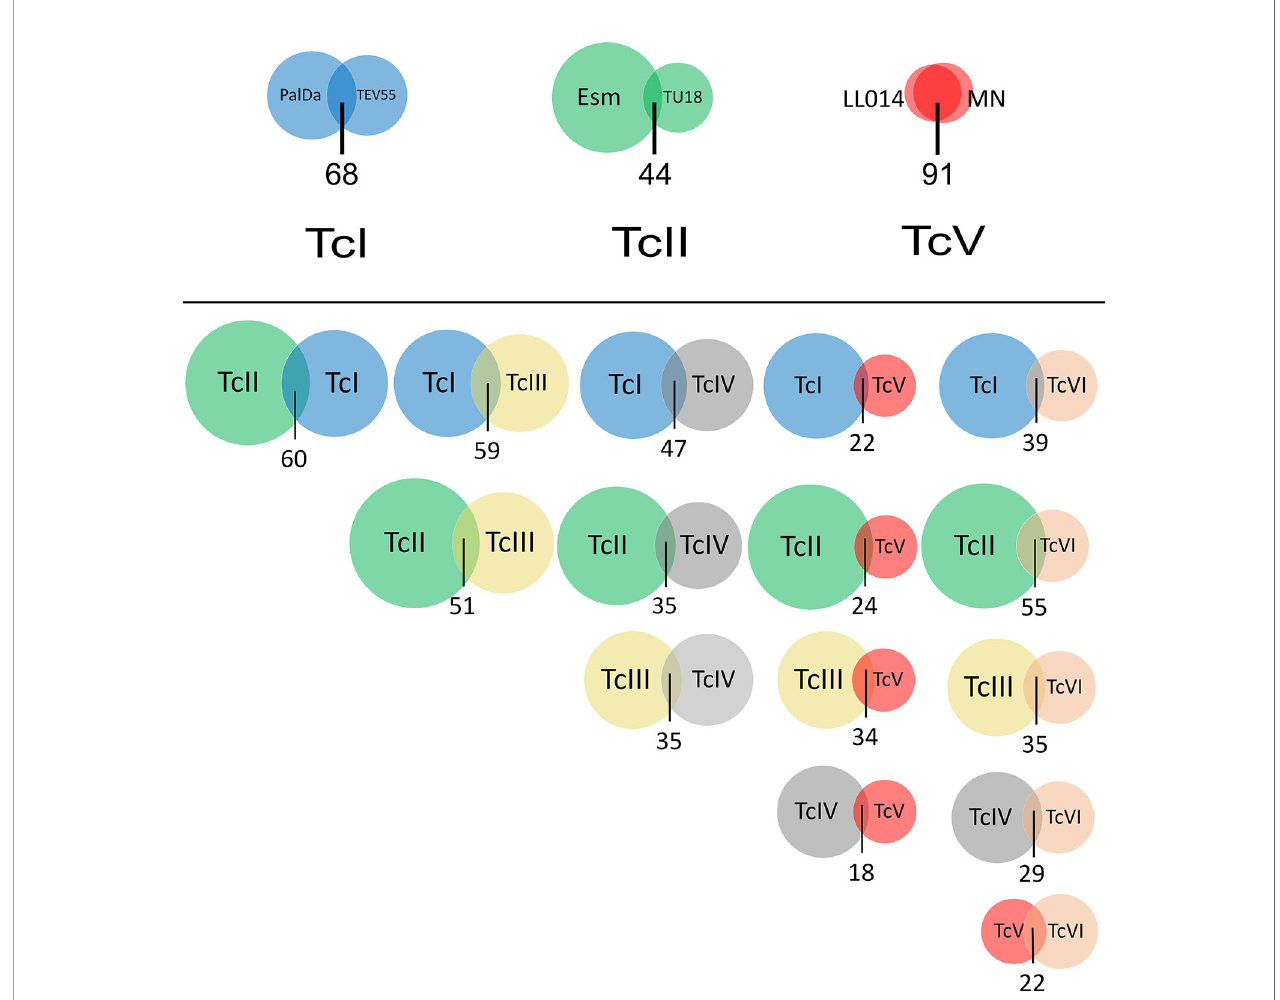
FIGURE 2 | Venn diagrams showing overlapping gRNA repertoires between strains of the same DTU and between DTUs. Circle size represents the number of gRNA classes identi fi ed in a strain (above) or in a DTU (below). The overlapping area among circles indicates gRNA classes with more than 20 reads that are shared between strains or DTUs. The number below circles represents the percentage of shared gRNA classes. PalDa=PalDa20cl3, TEV=TEV55cl1, Esm=Esmeraldo, X109=X109/2, Tu18=Tu18cl93, MN=MNcl2 and LL014=LL014R1.